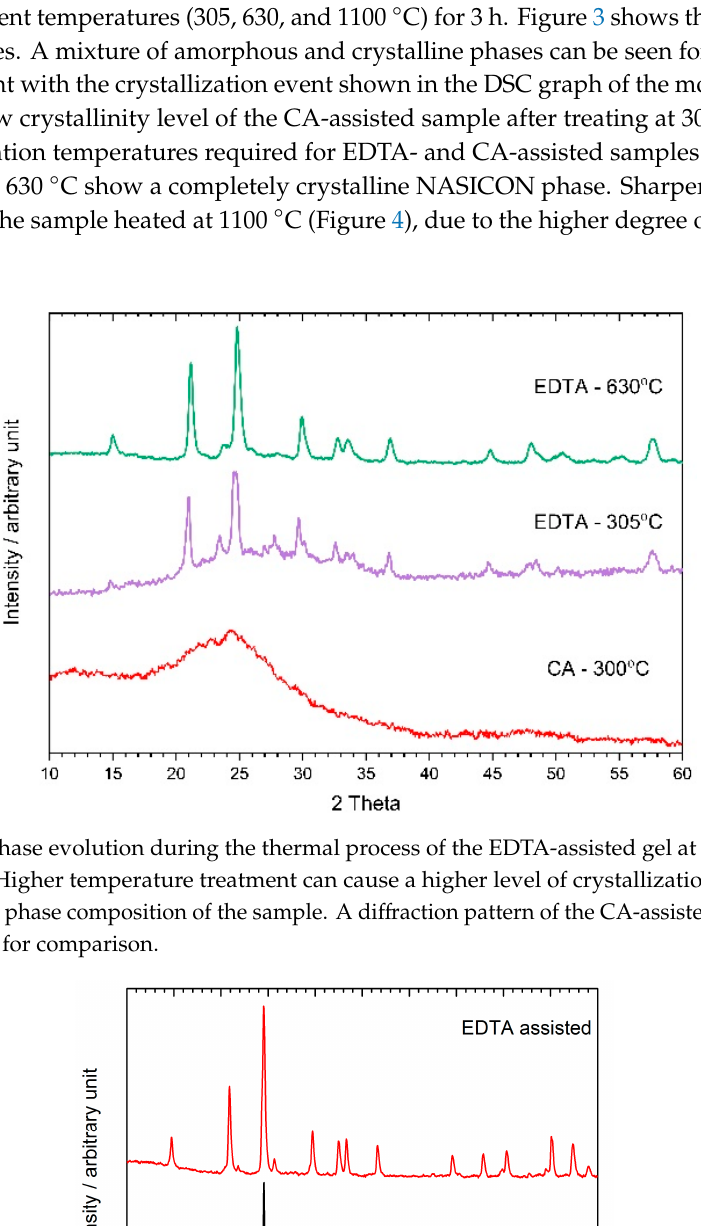
Table 1. The calculated lattice parameters from the Le-bail fitted XRD patterns obtained from the sol– gel prepared samples with two different complexing agents.